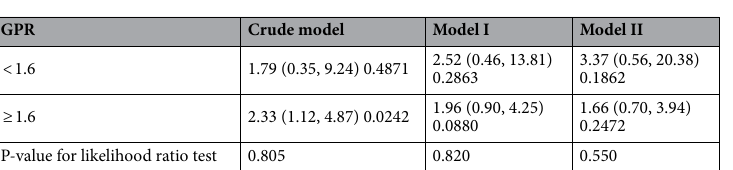
Table 4. Two-piecewise linear regression analysis for GPR and 30-day mortality. Data were depicted as OR (95% CI) P-value. GPR serum glucose to potassium ratio. Crude model: not adjusted. Mode I: Adjusted for age and gender. Mode II: Adjusted for age, gender, department, serum sodium, serum albumin, serum-magnesium tertiles, hypertension, heart failure, chronic renal failure, and pneumonia.